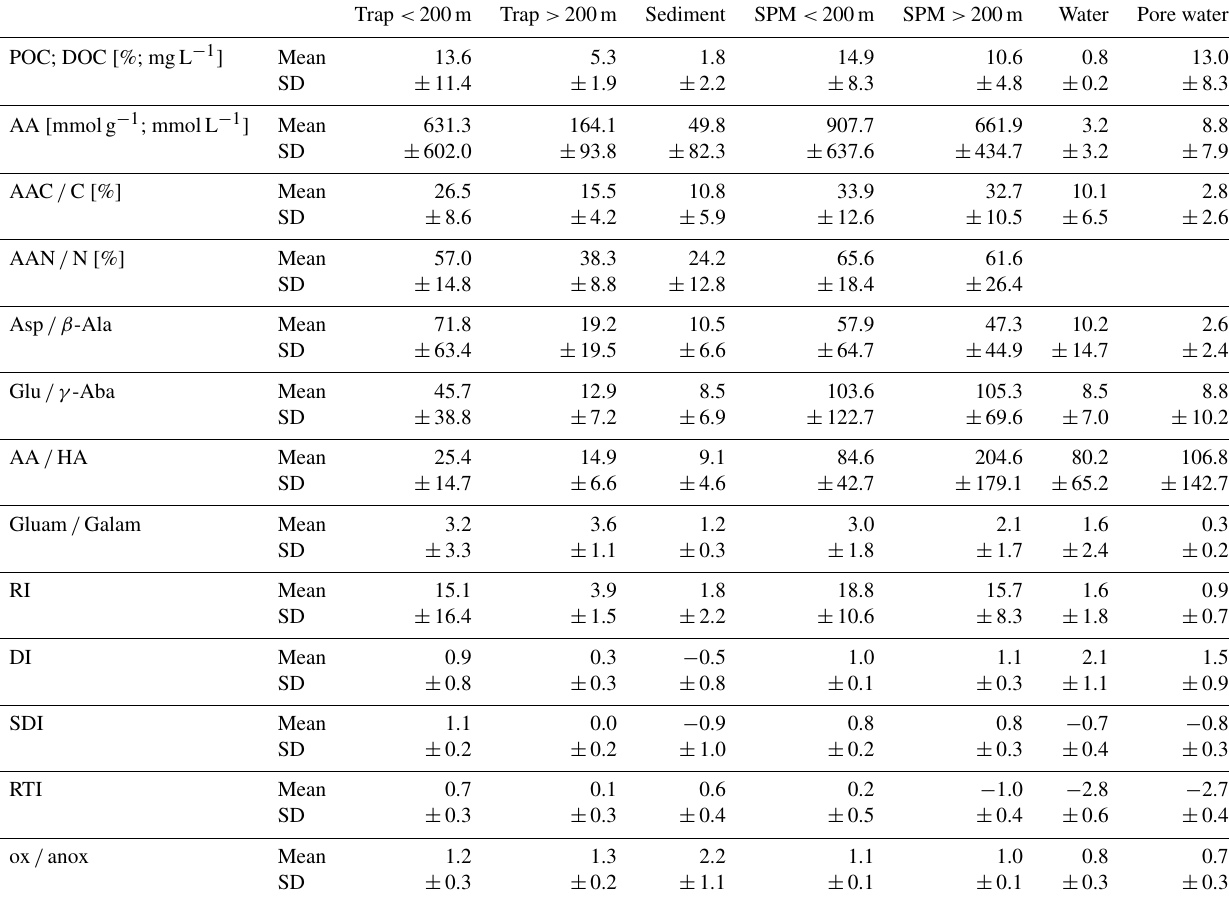
Table 1. Mean values and standard deviation (SD) of POC [%]; DOC [mgL − 1 ]; amino acid (AA) concentrations [µmolg − 1 or µmolL − 1 ]; AAC / C%; AAN / N%; ratios of Asp /β -Ala, Glu /γ -Aba, AA / HA, and Gluam / Galam; RI; DI; SDI ∗ ; RTI ∗ ; and ox / anox ratio summa- rized in traps at < 200 and > 200m water depth, sediments, SPM < 200 and > 200m water depth, water samples, and pore water samples. Trap <